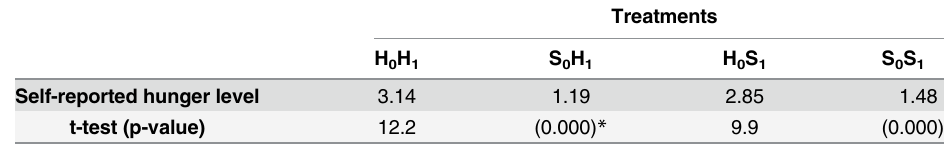
Table 3. Level of self-reported participants´hunger between treatments.